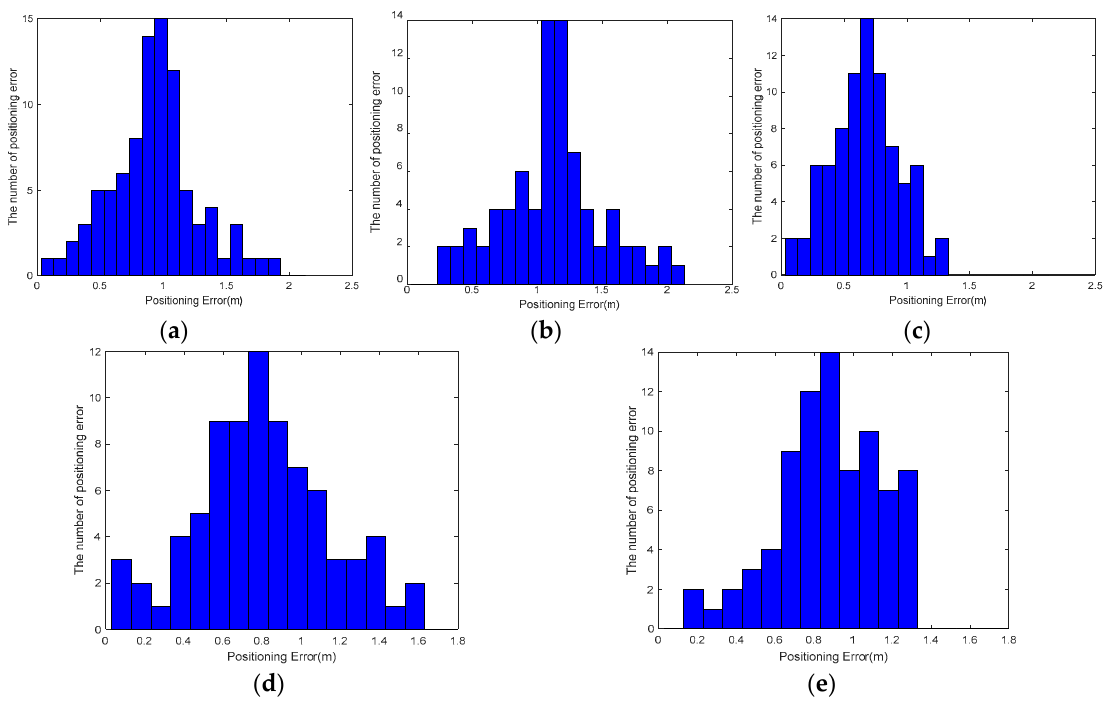
Figure 5. Histogram of the positioning error in the Scenarios 3. ( a ) PSO method; ( b ) Chan method; ( c ) PSO ‐ IMChan method; ( d ) WLS method; and ( e ) RWGH method.